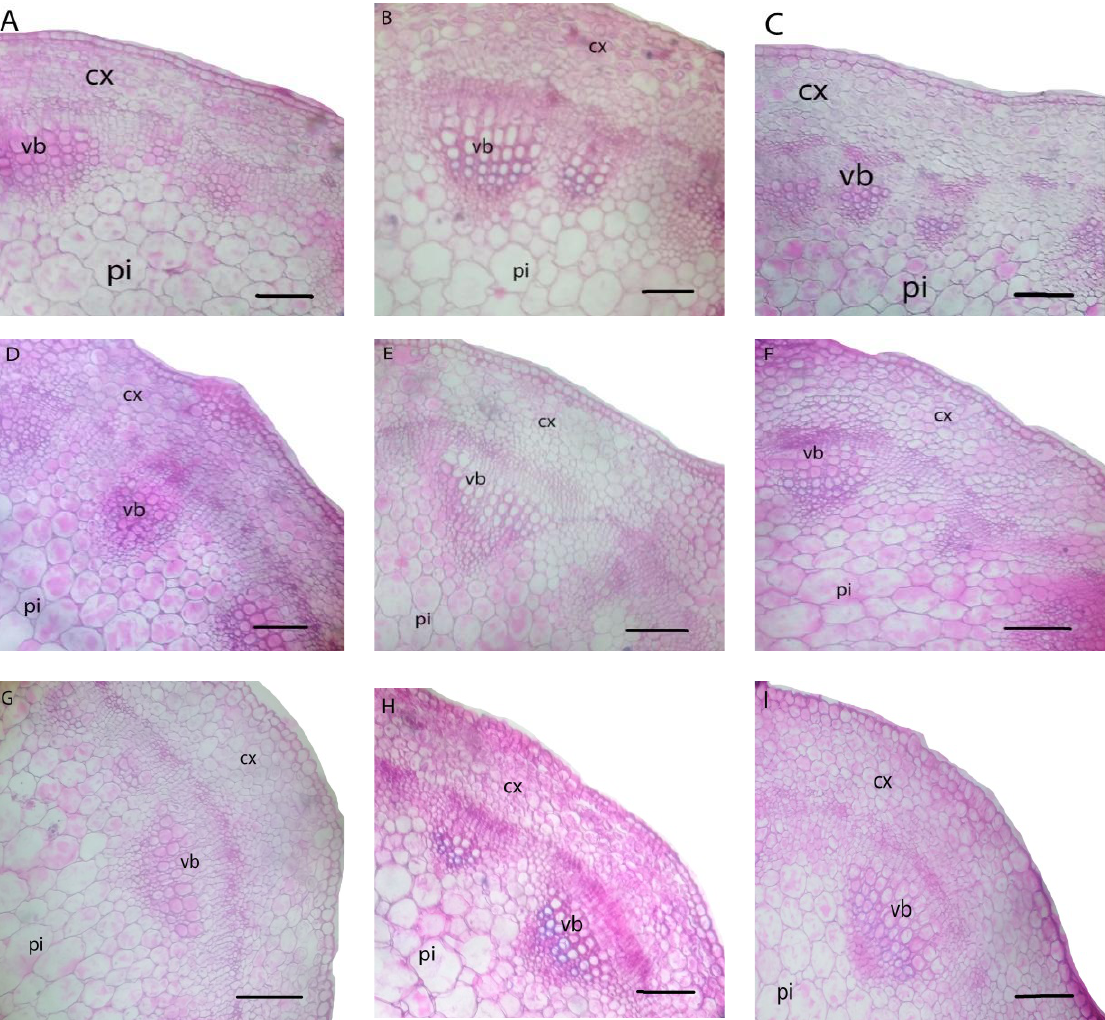
Figure 3. Stem anatomy of fenugreek plants grown under different irrigation levels and phosphorus nanoparticles treatments. ( A ) dI−00 x cP; ( B ) dI−00 x nP−1; ( C ) dI−00 x nP−2; ( D ) dI−20 x cP; ( E ) dI−20 x nP−1; ( F ) dI−20 x nP−2; ( G ) dI−40 x cP; ( H ) dI−40 x nP−1; ( I ) dI−40 x nP−2; (cx =cortex, vb = vascular bundle and pi = pith). Scale bar = 140 µ.